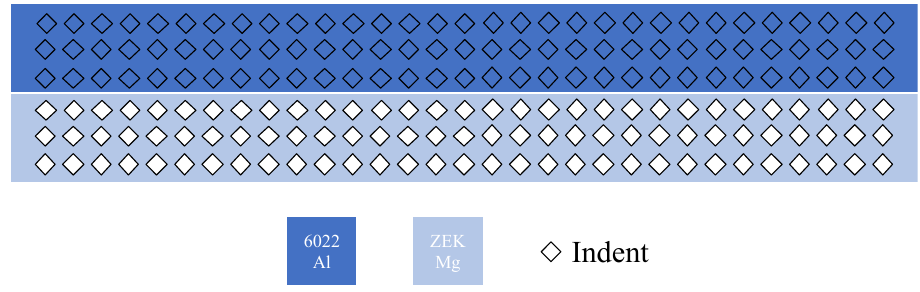
Figure 2. Schematic microindentation experimental design.